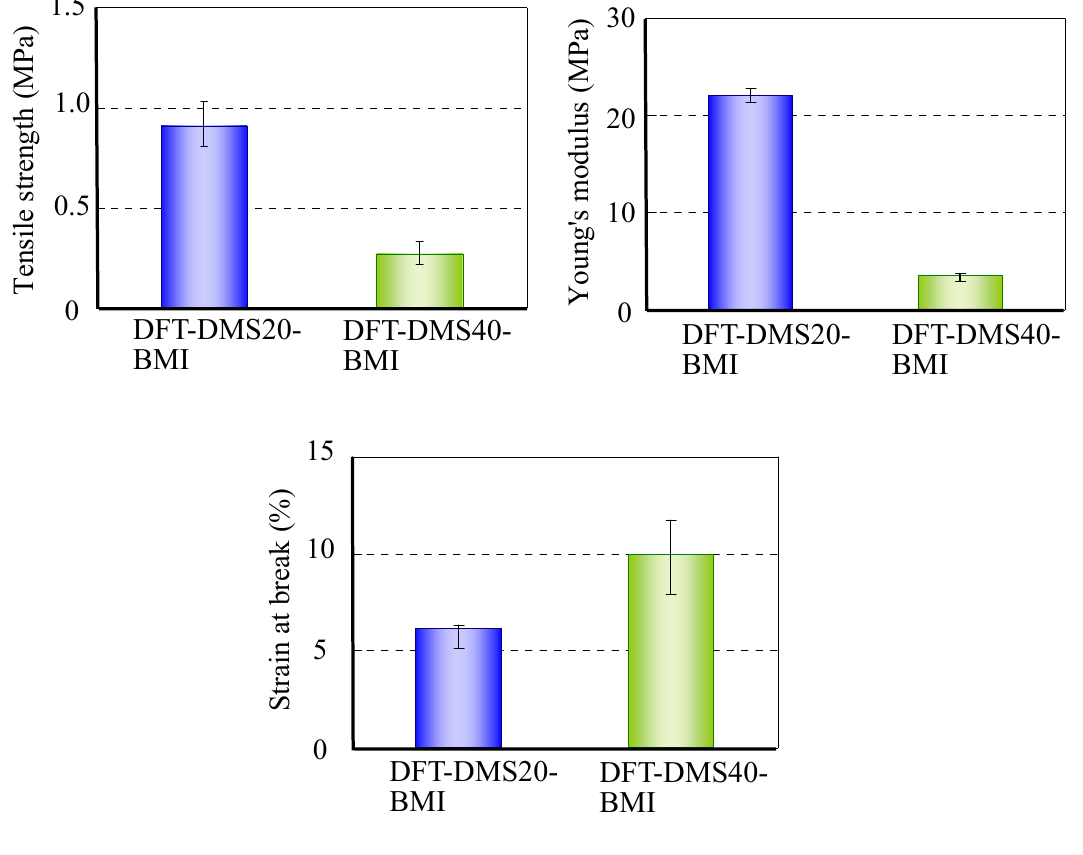
Figure 7. Tensile properties of DFT-DMS20-BMI and